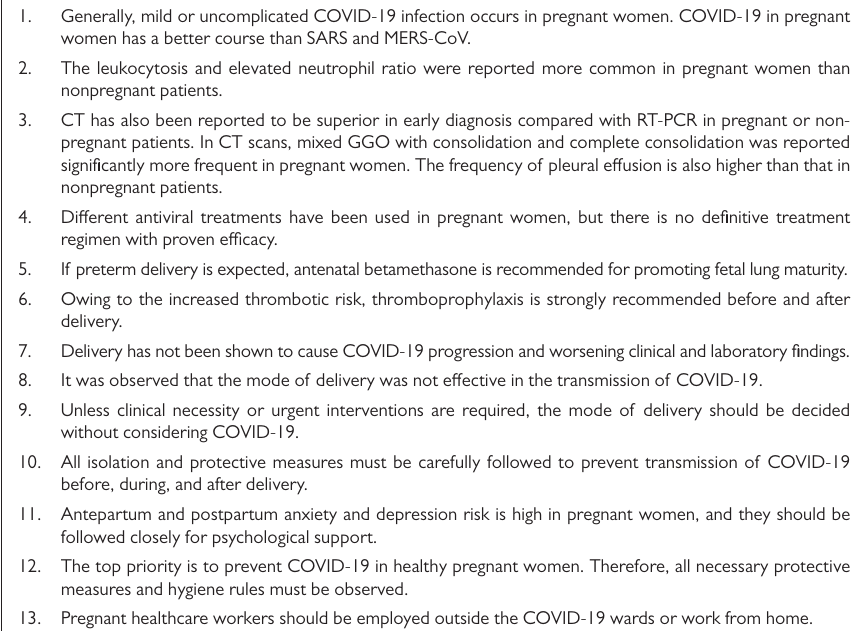
Table 1. Information highlighted in pregnant women with